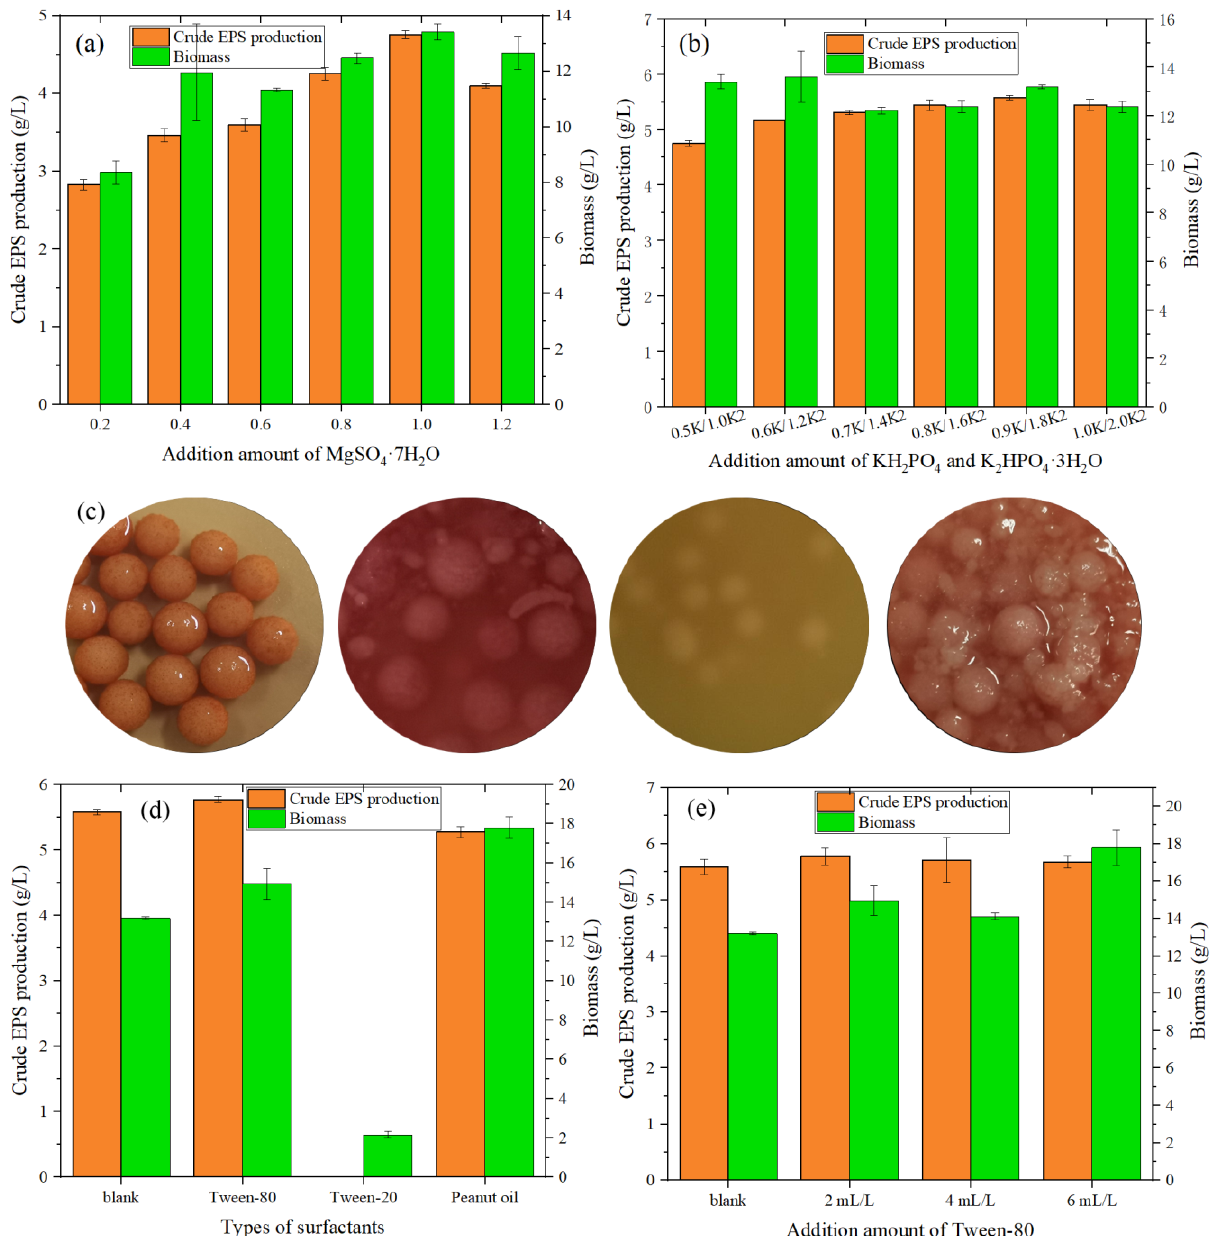
Figure 3. ( a ) Effect of MgSO 4 ·7H 2 O on the crude EPS production and biomass of MAL . ( b ) Effect of KH 2 PO 4 and K 2 HPO 4 ·3H 2 O on the EPS and biomass of MAL . ( c ) Liquid culture medium of MAL with different surfactants (from left to right: blanks, with Tween-80, with Tween-20, and with peanut oil). ( d ) Effect of surfactant type on the crude EPS production and biomass produced by MAL . ( e ) Effect of Tween-80 addition on the EPS and biomass of MAL .